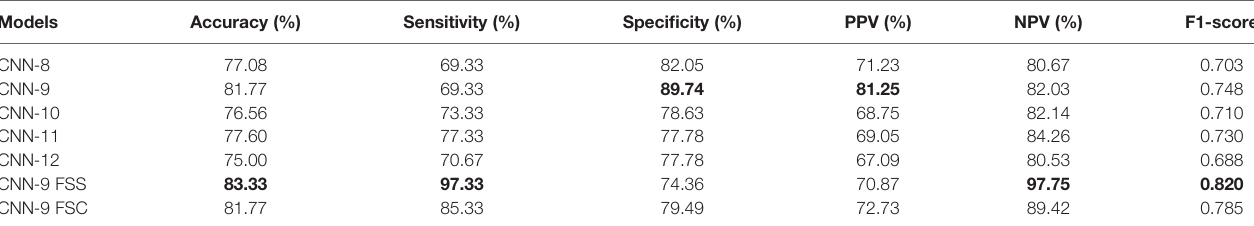
TABLE 5 | Performance of the model with different convolution layer numbers and feature-sharing methods.